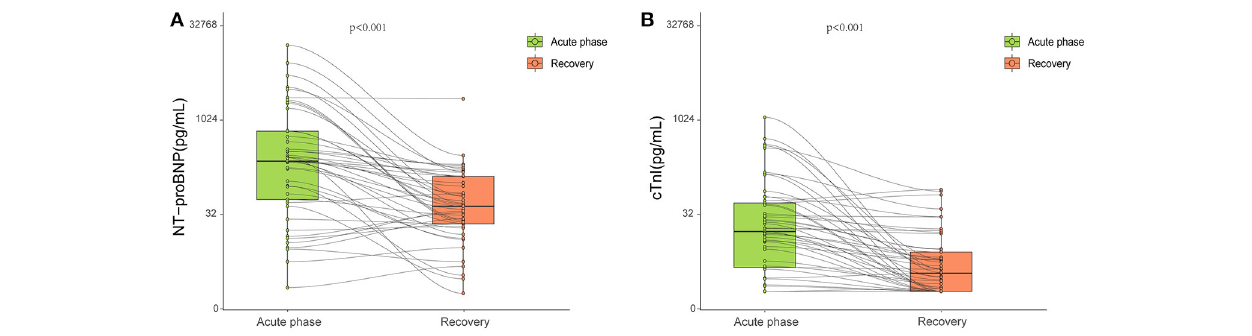
FIGURE 2 | Blood biomarkers obtained at the acute phase and late after the recovery. During hospitalization, serum NT-proBNP (A) and cTnI (B) levels were available in 45 and 64 patients, respectively. Both were significantly decreased 327 days after diagnosis compared with those in the acute phase ( p < 0.001). Each small circle represents a value. The top and bottom of the rectangle represent the interquartile range. Bold black lines in the rectangle indicate